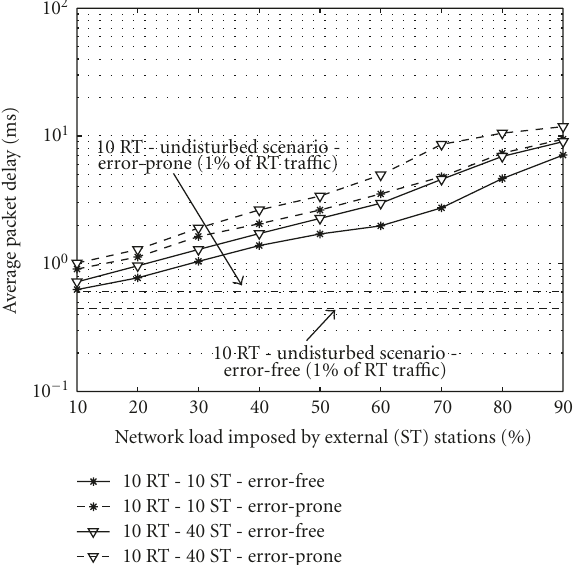
Figure 6: Average delay (small and large pop.): error-free versus error-prone—MSP = 10